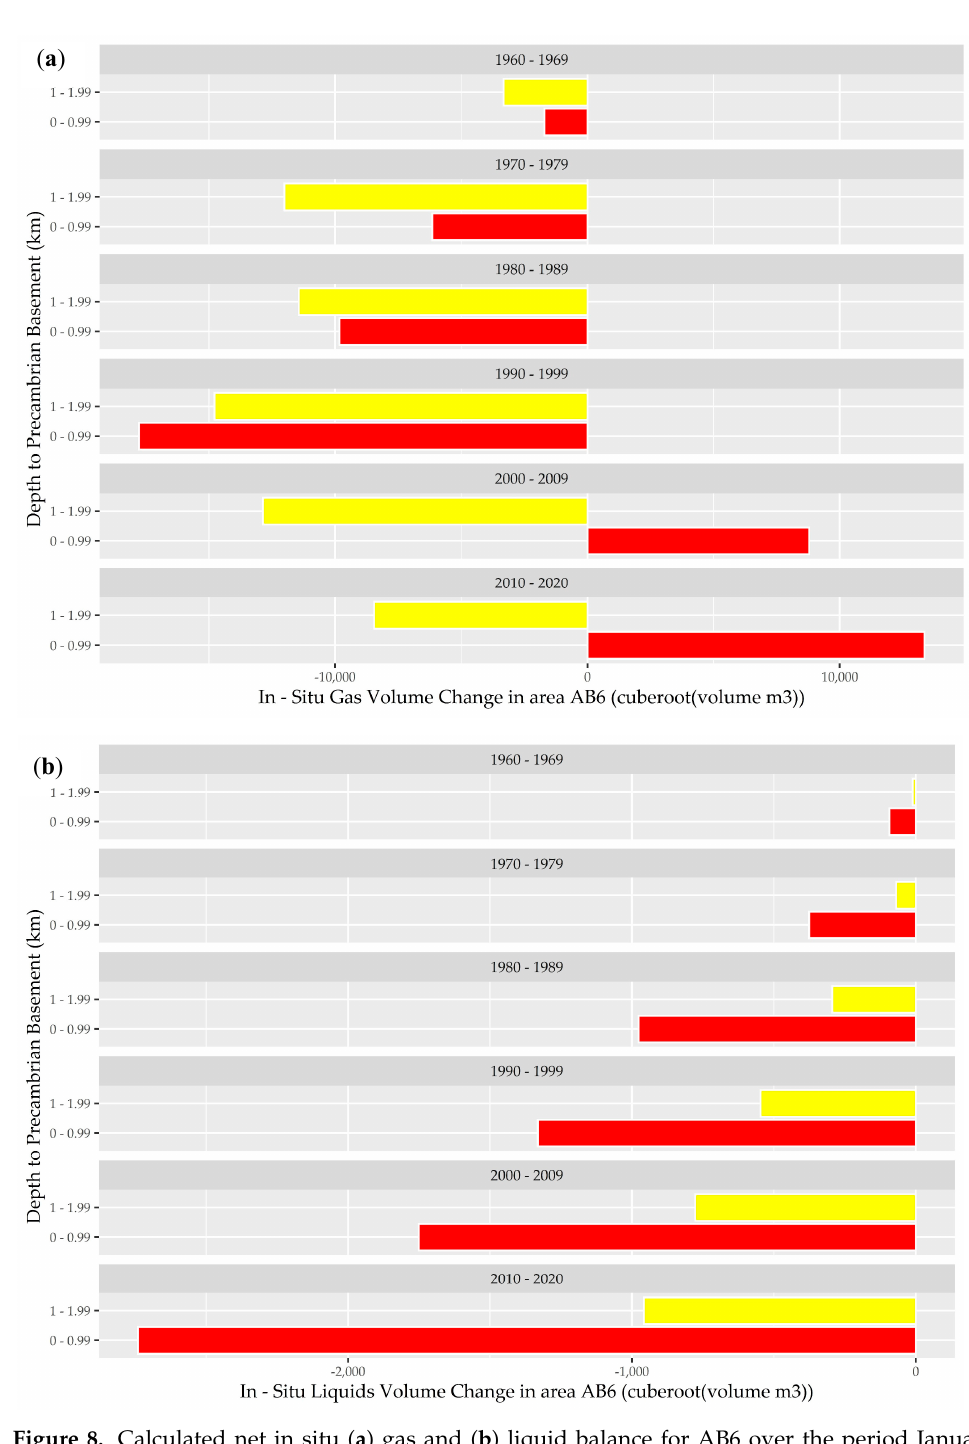
Figure 8. Calculated net in situ ( a ) gas and ( b ) liquid balance for AB6 over the period January 1960–December 2020. Red bars: <1 km depth from Precambrian basement; Yellow bars: 1–2 km depth from Precambrian basemen. Source data extracted from geoLOGIC Systems databases ©